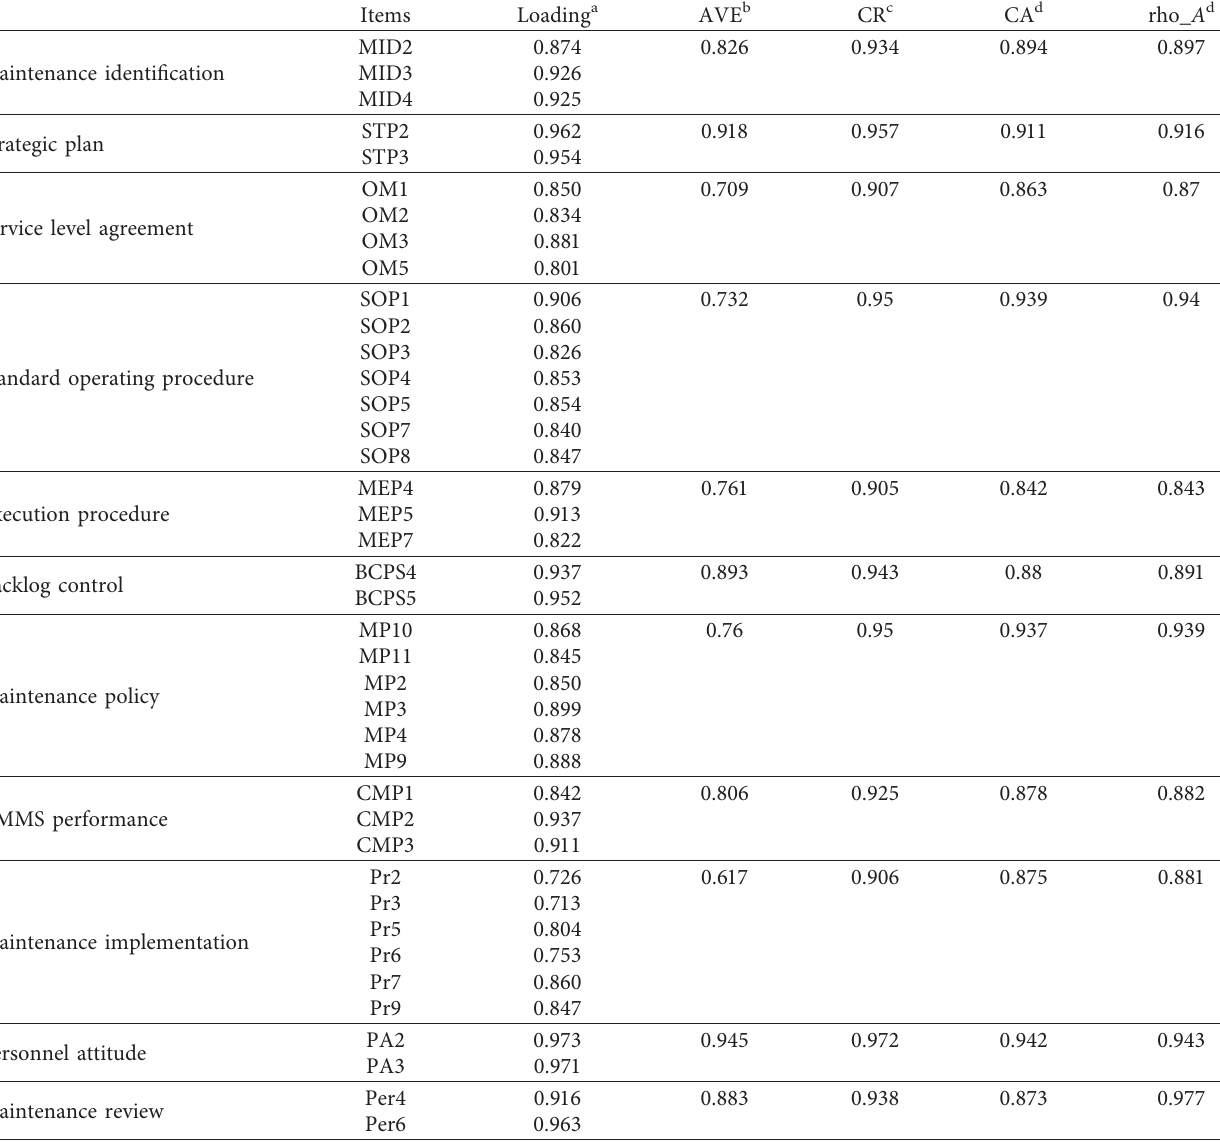
Table 2: Measurement model for performance of